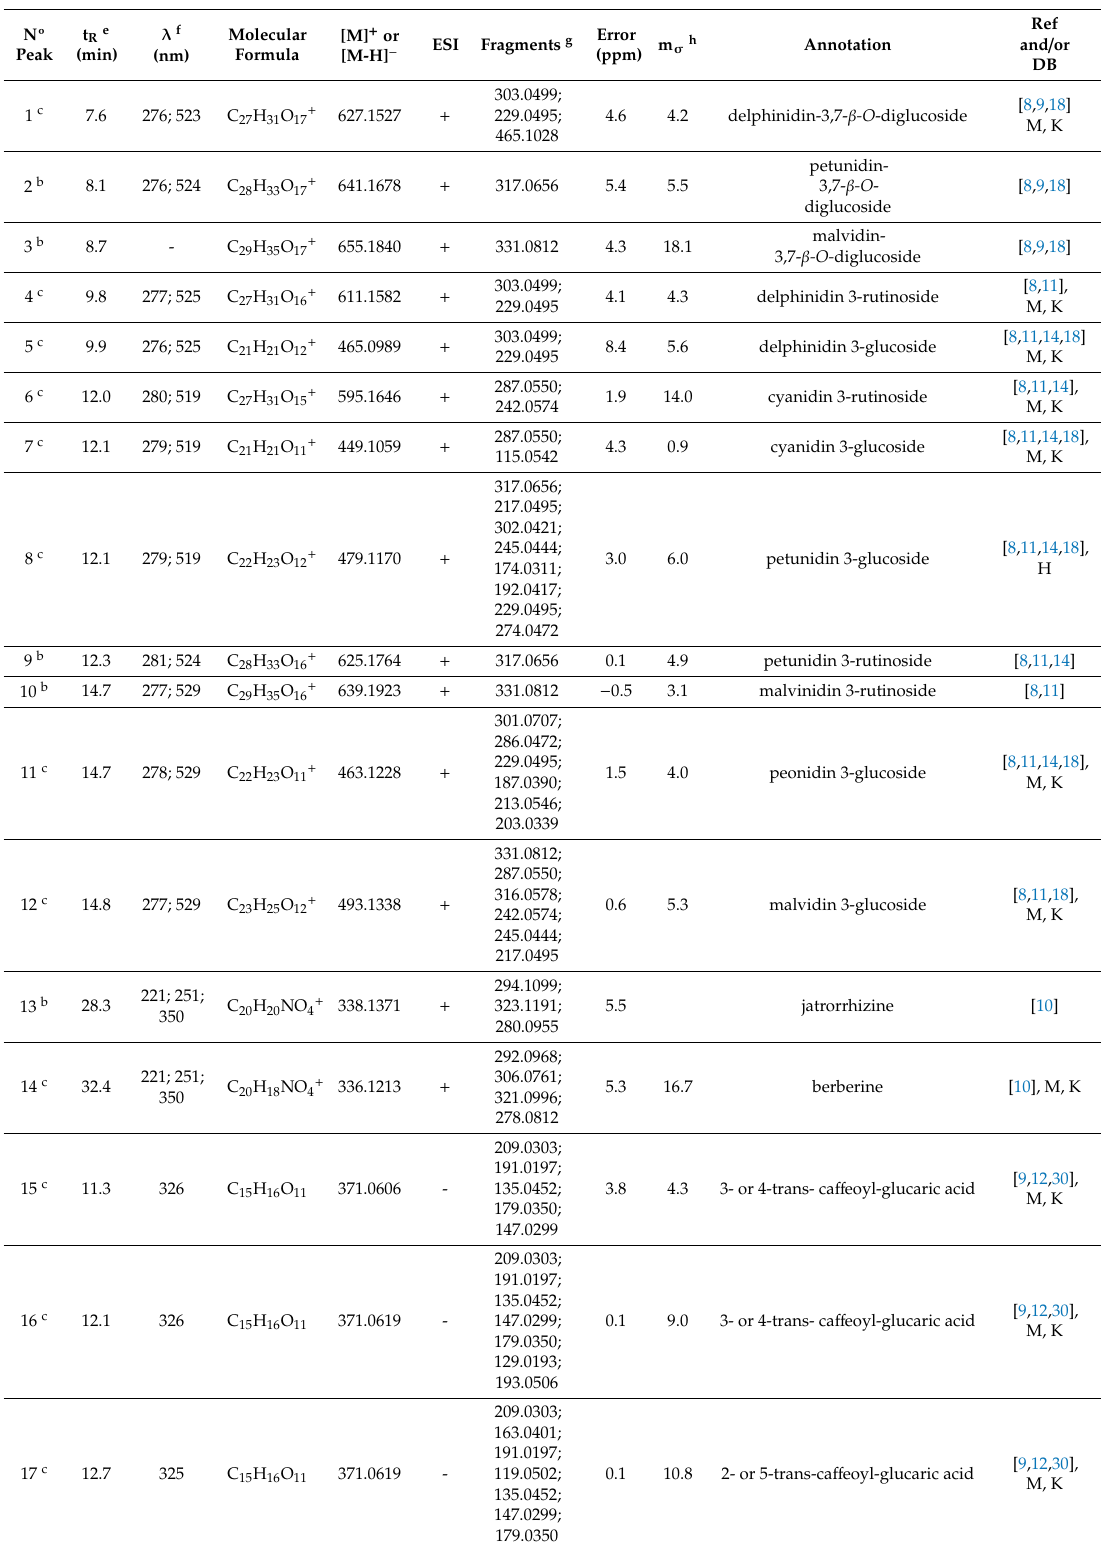
Table 1. Metabolic profile of calafate obtained by UHPLC-DAD-QTOF in positive and negative ionization